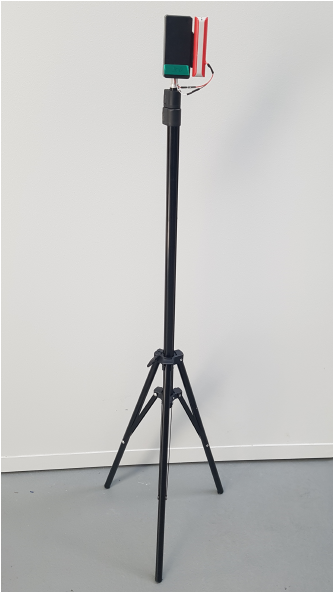
Figure 14. UWB anchor.